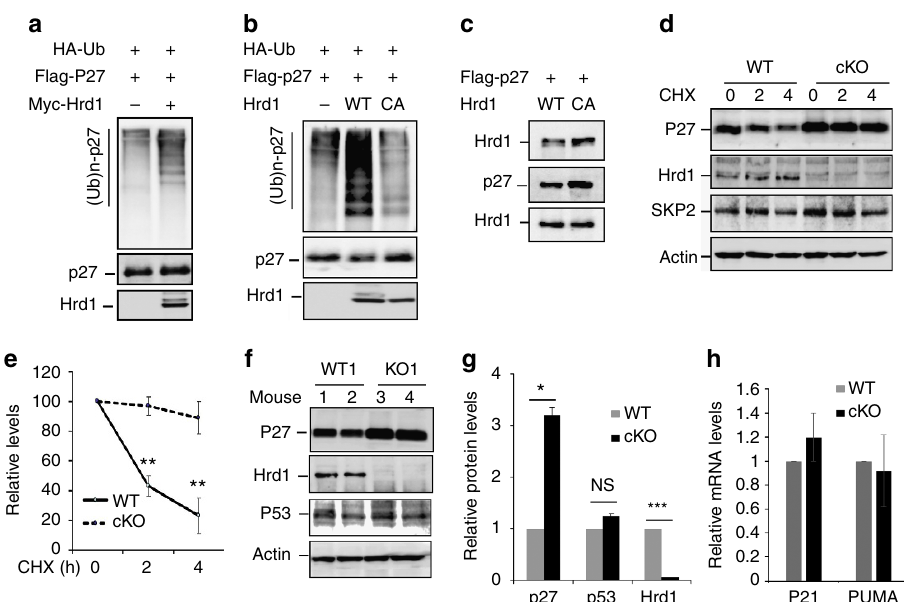
Figure 4 | Hrd1 is an E3 ubiquitin ligase of p27 kip1 . ( a , b ) Flag-p27 and HA-Ub expression plasmids were co-transfected with Myc-Hrd1 or its CA mutant. p27 kip1 protein ubiquitination was determined by immunoprecipitation of p27 kip1 protein and immunoblotting with anti-HA antibodies (top panels). The same membranes were re-probed with anti-Flag (middle panels) and Hrd1 expression in the whole-cell lysates was confirmed by immunoblotting with anti-Myc antibody (bottom panels). ( c ) The interaction of p27 with both WTand Hrd1/CA mutant in transiently transfected 293 cells were analysed. ( d , e ) WT and Hrd1 cKO CD4 T cells were cultured with anti-CD3 plus anti-CD28 overnight and then chased by cycloheximide (CHX) for the indicated times. The protein expression levels of p27, Hrd1, SKP2 and the loading control b -actin were examined by immunoblotting using each specific antibody. Representative images ( d ) and quantifications of five independent experiments ( e ) are shown. ( f – h ) The protein expression levels of p27 kip1 , Hrd1, p53 and b -actin in WT and Hrd1 cKO CD4 T cells were determined by immunoblotting ( f ), and the average levels from five pairs of mice are indicated ( g ). Total RNA was extracted from stimulated cells and the expression levels of p21 and PUMA were analysed by real-time PCR with reverse transcription ( h ). Mann–Whitney test was used for the statistical analysis. NS, no significant difference; * P o 0.05, ** P o 0.01 and *** P o 0.001.